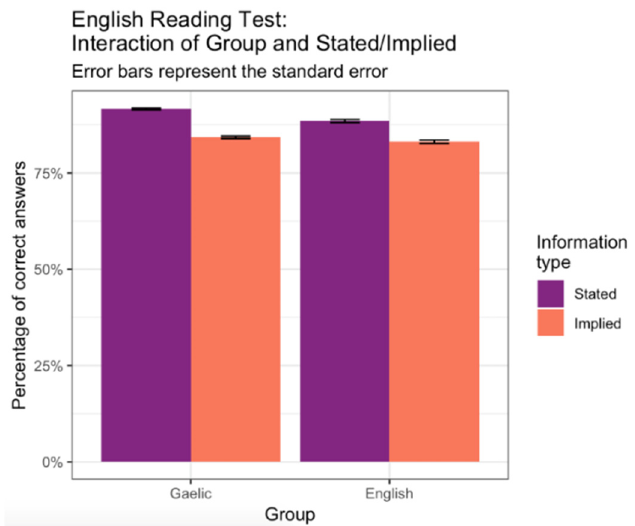
Figure 8. English Reading for All score by types of information and group.